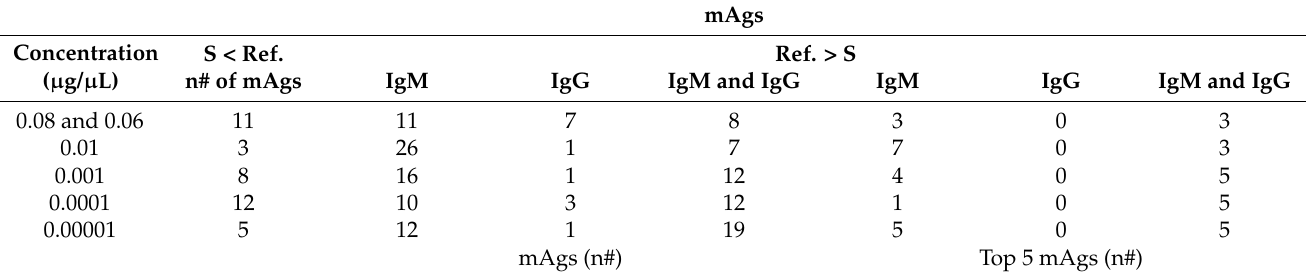
Table 2. Global number of microbial antigens (mAgs) detected in this screening after analysis of 37 different